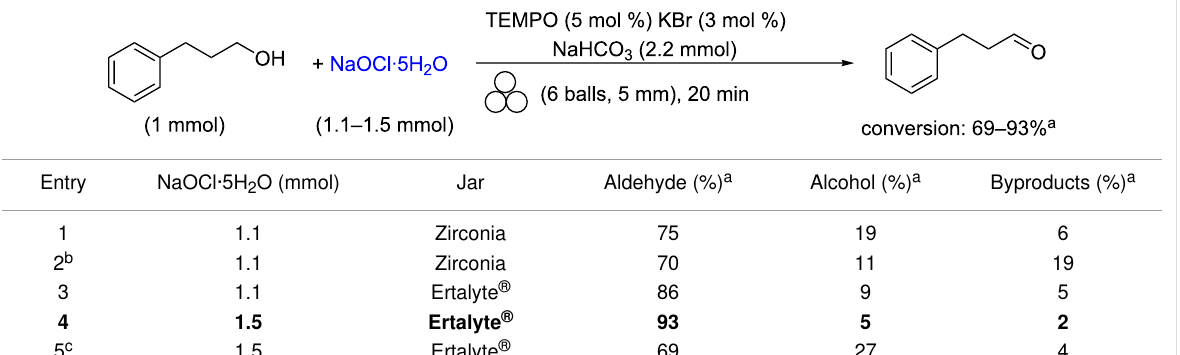
Table 2: Oxidation of 3-phenyl-1-propanol ( 1a ) with NaOCl·5H 2 O crystals under mechanical activation conditions using ZrO 2 or Ertalyte ® jars. Optimi- zation of the reaction conditions.